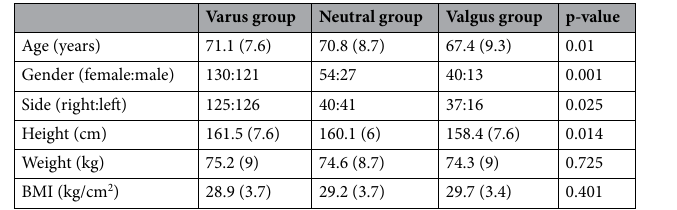
Table 1. Patient demographic data of the varus, neutral and valgus group. Data are presented as the mean and (standard deviation). BMI body mass